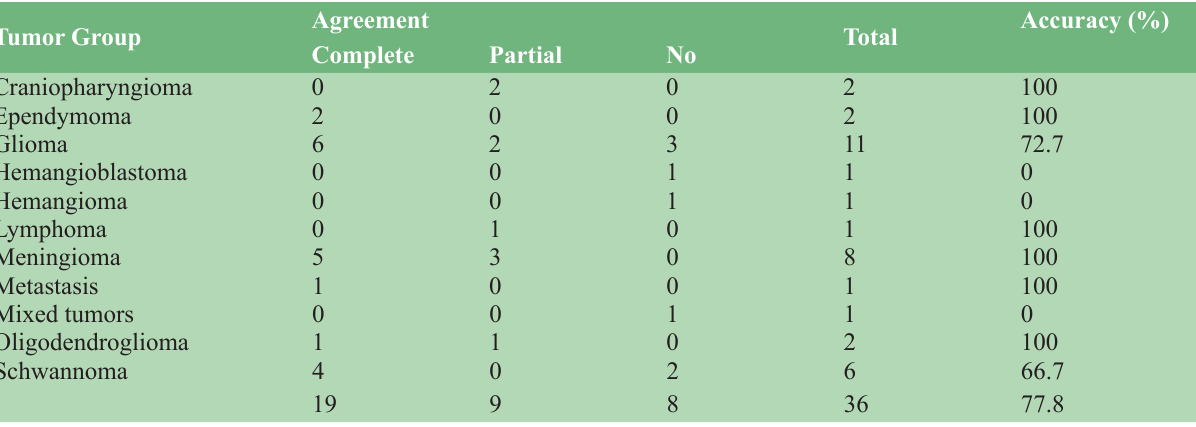
Table 2: Correlation of squash cytology with histopathological examination among various tumor